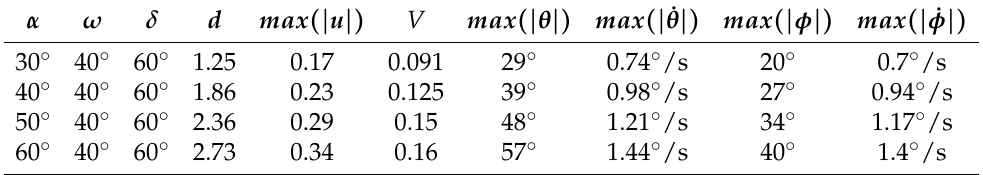
Table 1. Simulation results for different amplitudes α